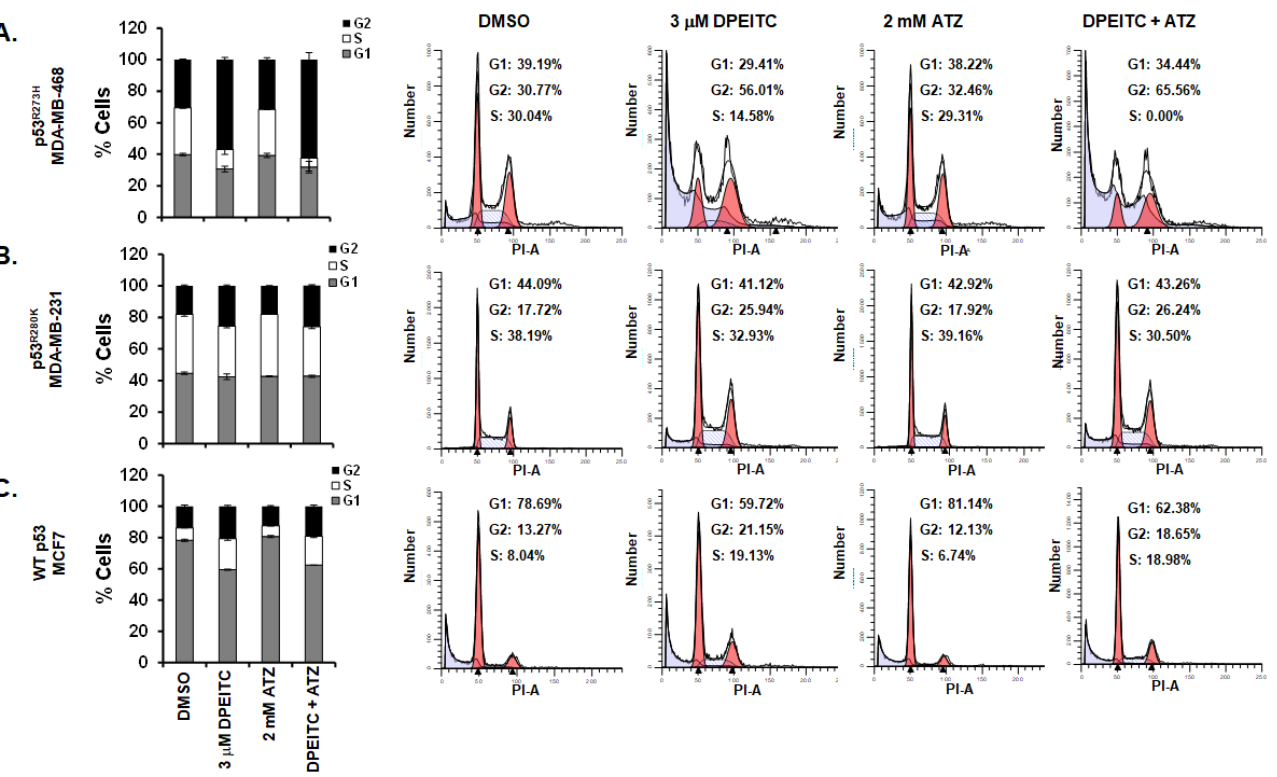
Figure 3. Effects of DPEITC and ATZ co-treatment on cell cycle progression in TNBC cell lines. p53 R280K MDA-MB-231 ( A ), p53 R273H MDA-MB-468 ( B ), and WT p53 MCF7 ( C ) cells were treated with DMSO, 3 μM DPEITC, 2 mM ATZ, or 3 μM DPEITC and 2 mM ATZ for 72 h and analyzed by flow cytometry. Experiments were performed in triplicate. Error bars represent SD. Representative cell cycle images are shown.